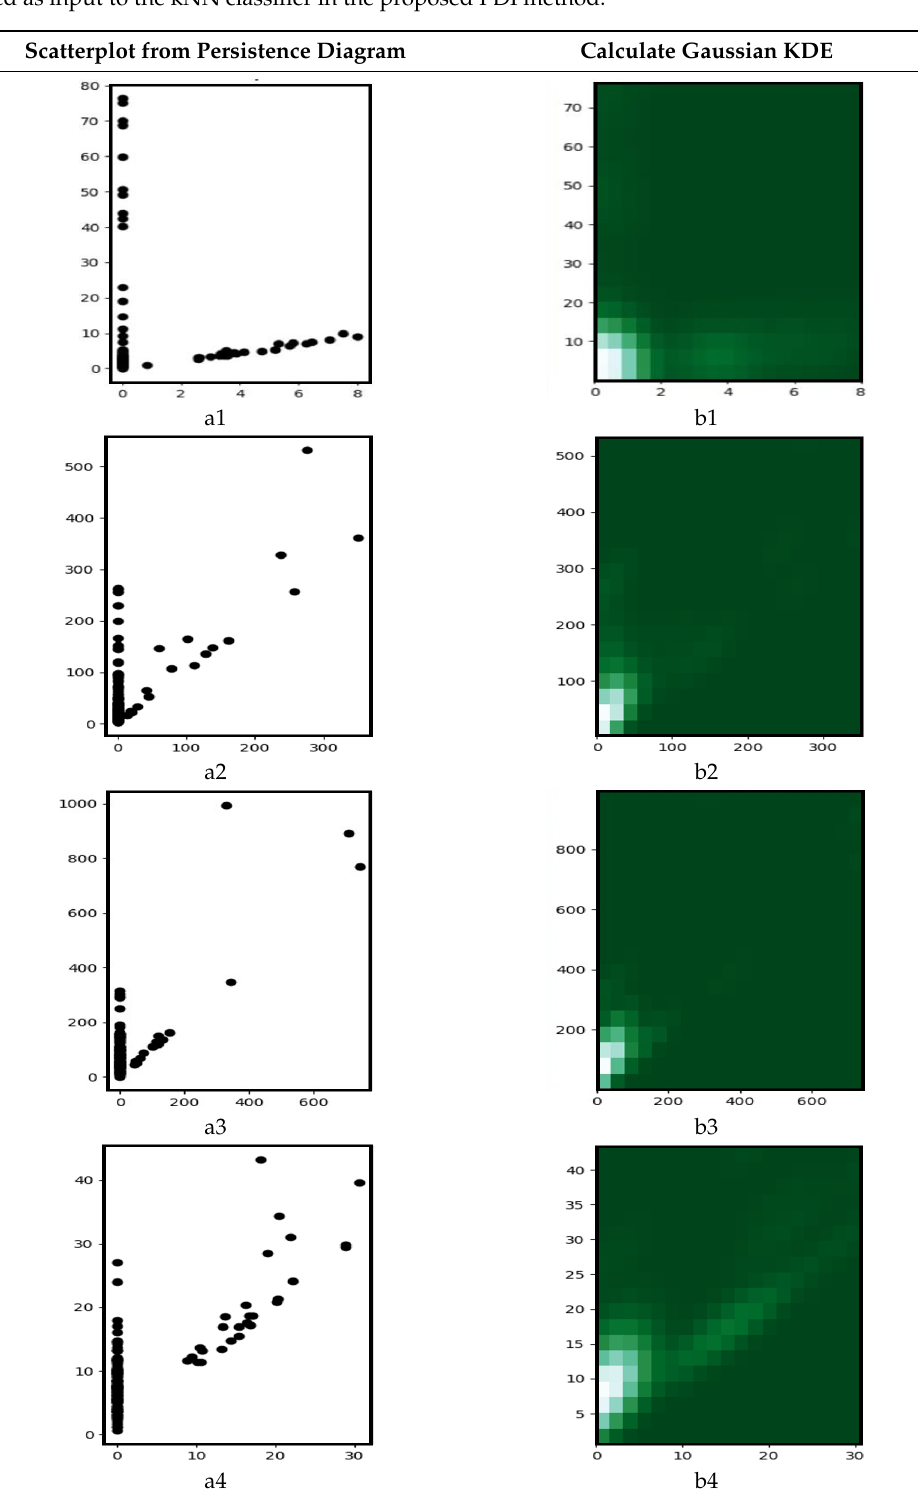
Table 4. Persistence Diagrams (left) a 1 , a 2 , a 3 , a 4 and representation of Calculate Gausssian KDE (right) b 1 , b 2 , b 3 , b 4 for classes Normal , Other , VT and VF , respectively. The representation of KDE is used as input to the kNN classifier in the proposed PDI